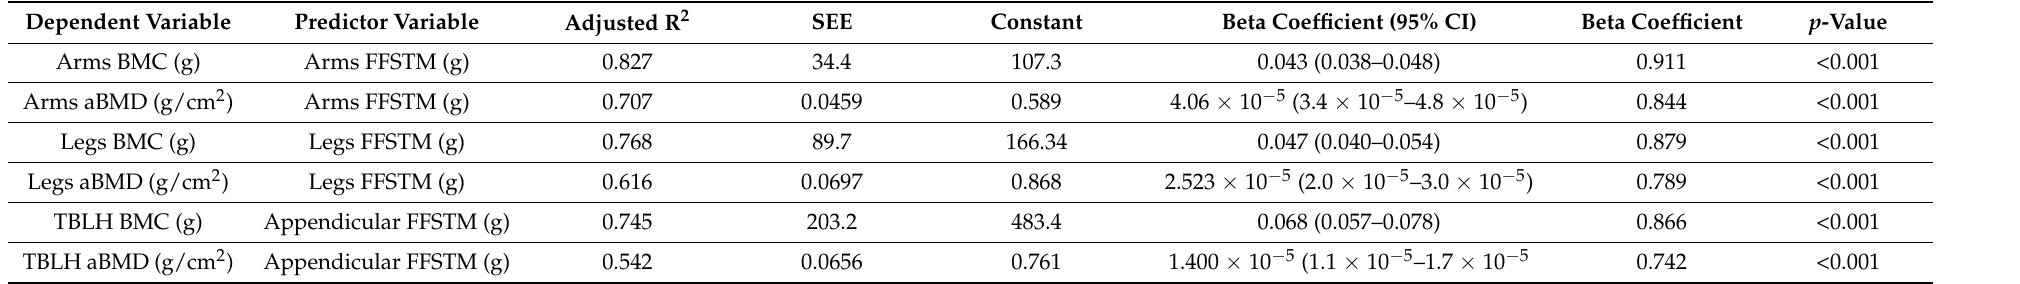
Table 7. Results of linear regression analysis in the whole group of karatekas (n =